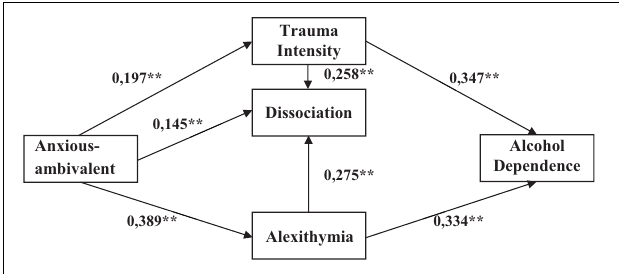
FIGURE 4 | Standardized estimates for models taking into account the anxious-ambivalent attachment style. * p < 0.05 and ** p < 0.01. Source: Zdankiewicz- ´Scigała